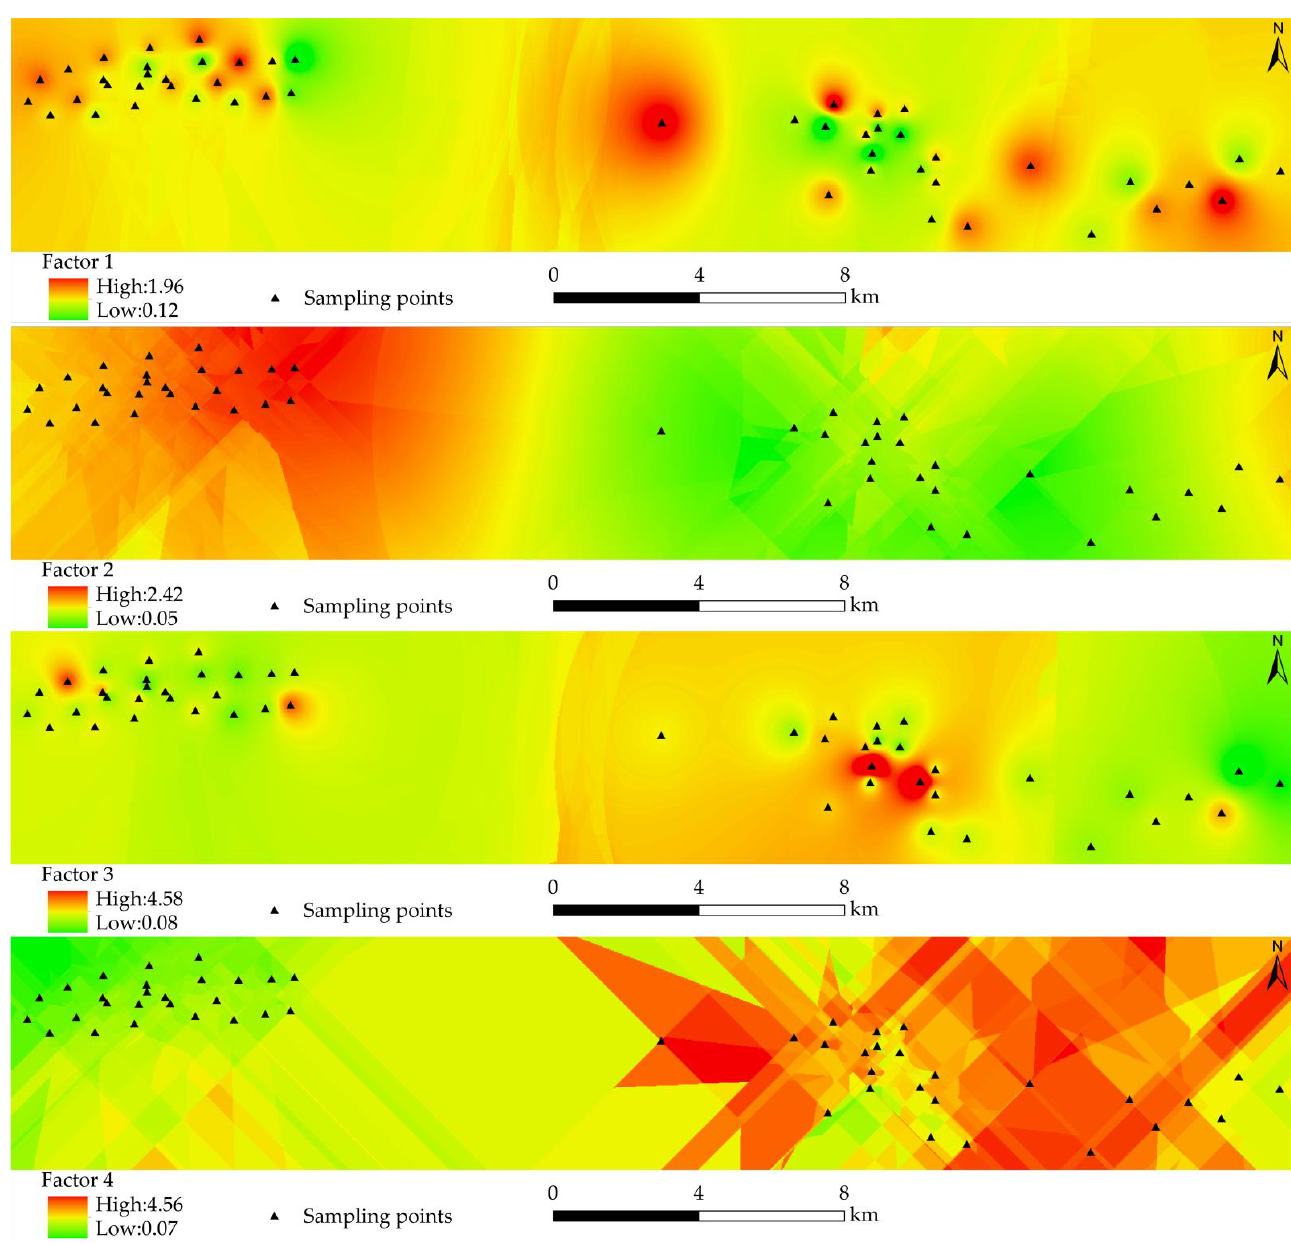
Figure 5. The factor contribution rates of heavy metals are calculated by the PMF.